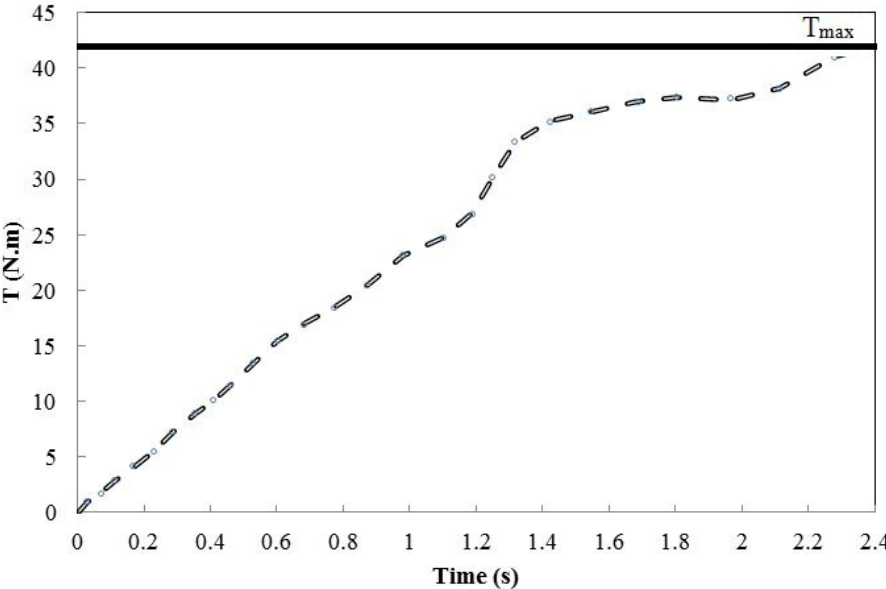
Figure 9. Evolution of the smoothened reaction moment of the soil with a friction angle of 34 ◦ and a vertical effective stress of 110 kPa ( t = 2.4 s is the time for one complete rod rotation).